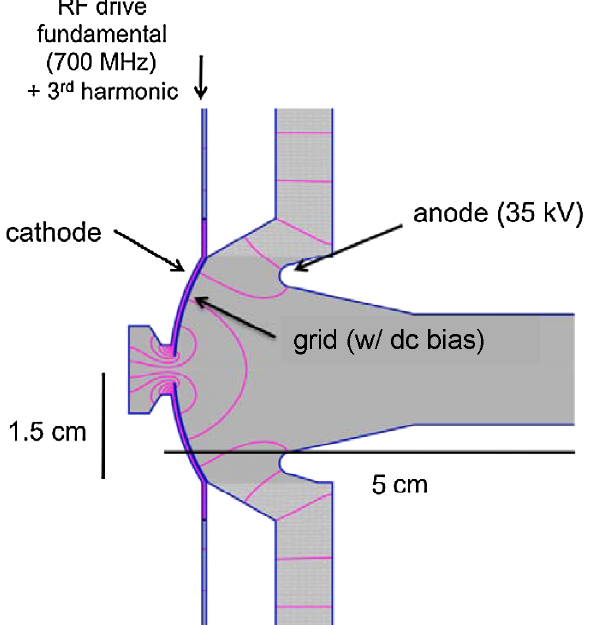
FIG. 14. Geometry of a thermionic IOT gun used for the PARMELA simulations of Fig. 17. The cathode-grid gap is 0.25 mm. Fields driven at the fundamental (700 MHz) and third harmonic are injected into the cathode-grid region, and the grid has a bias of (cid:3) 450 V . The rf fields were computed using SUPERFISH , while the dc fields were computed using POISSON . Field lines of the fundamental (700 MHz) field are shown. The time-dependent potential at the location of the grid peaks at 160 V. The three-dimensional geometry is symmetric about an axis along the center of the